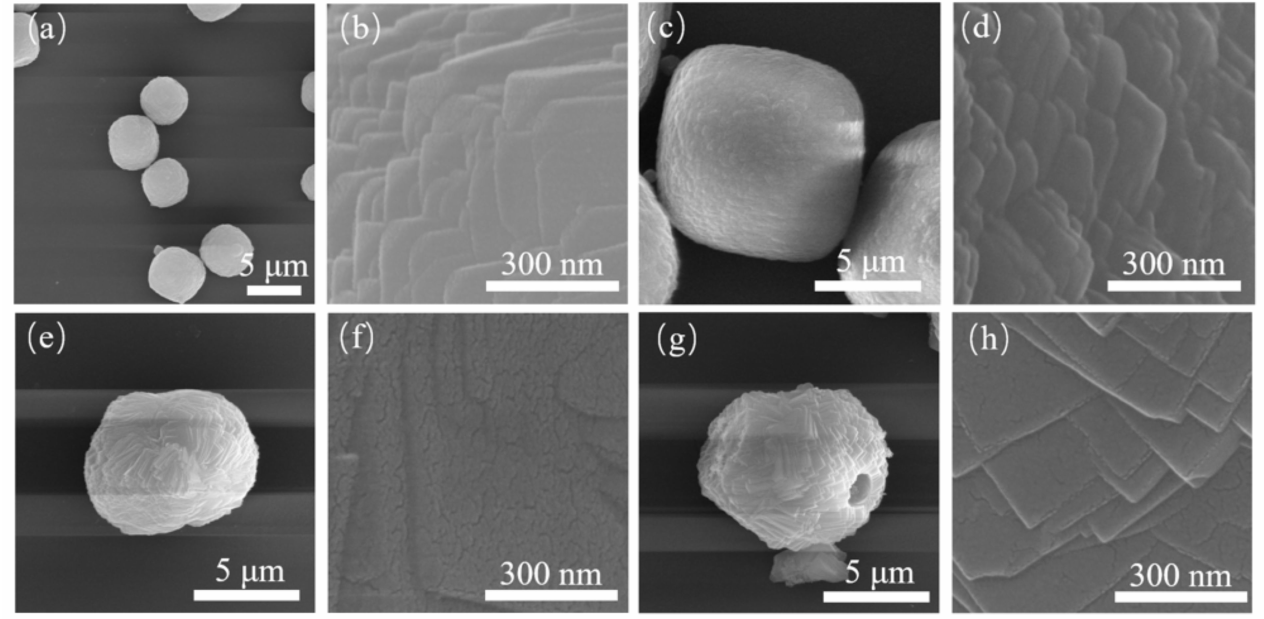
Figure 9. SEM diagrams of S-11 ( a , b ), S-12 ( c , d ), S-13 ( e , f ) and S-14 ( g , h